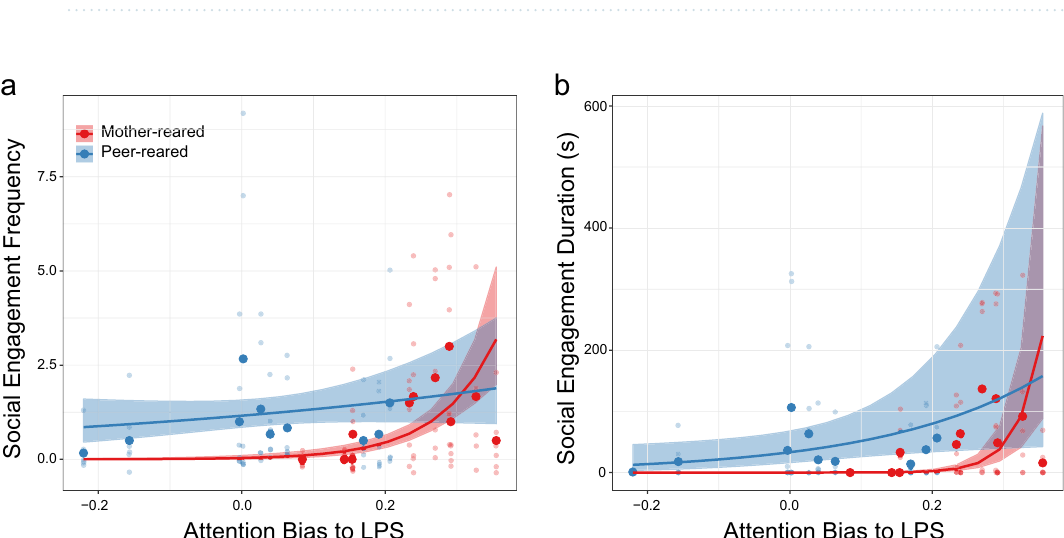
Figure 4. The relations between attention bias to LPS (i.e. to positive stimuli; ABP) and social engagement in the mother–reared (red) and peer-reared (blue) group. Each light-coloured dot represents an individual behavioural observation session, large dark-coloured dots represent the subject mean, dark lines indicate the model fit, and shaded regions around the lines denote + or −